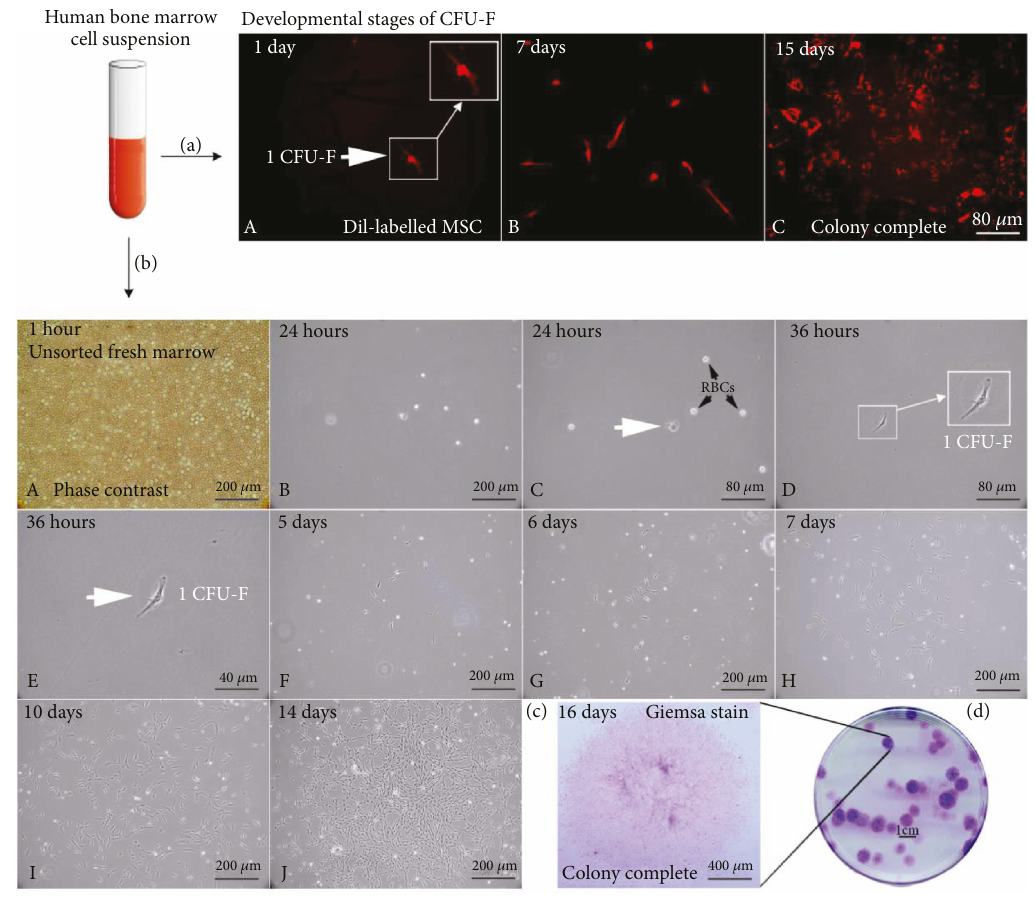
Figure 1: Growth phases from a BM CFU-F to a BM-MSC colony. (a) Developmental stages of primary CFU-F from human BM stromal DiI-labelled clonal cell to colony in culture (A – C) as observed by fl uorescence microscopy ( n = 5 ). (b) Development of an individual colony in human BM aspirate culture as observed by light microscopy ( n = 5 ). Time lapse microscopy of isolated clonal cells (white arrow) from BM after explant: cell division and migration (days 1-7); de fi ne territory and size of the forming colony; and subsequent proliferation abilities within the colony [days 7-15; (A – J)]. Establishment of complete colonies as demonstrated by Giemsa staining (c, d). Results are derived from 5 independent experiments and from 5 di ff erent donors. DiI: 1,1 ′ -dioctadecyl-3,3,3 ′ ,3 ′ -tetramethylindocarbocyanine perchlorate; CFU-F: Colony-Forming Unit Fibroblast; RBCs: Red Blood Cells. All data shown are representative results derived from one of at least three independent experiments. Scale bars represent 40 μ m, 80 μ m, 200 μ m, and 400 μ m and 1cm as